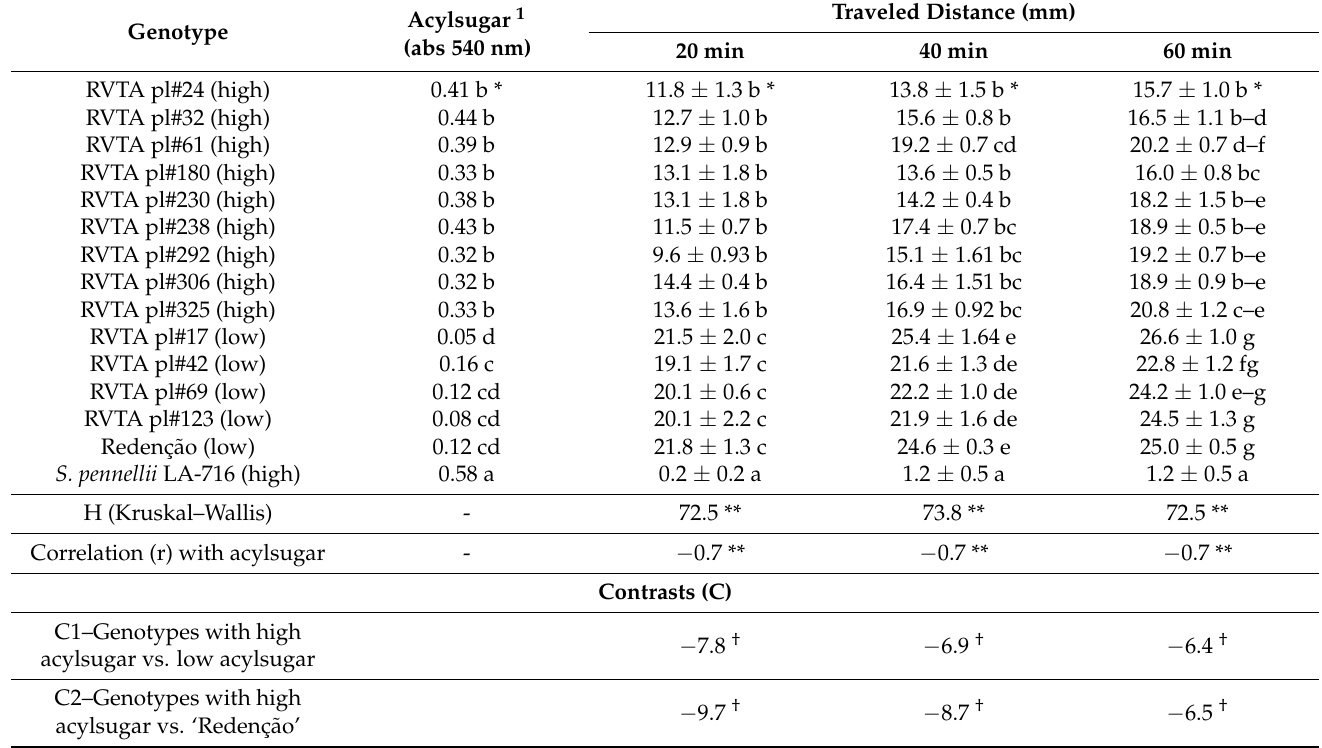
Table 5. Average ( ± standard deviation) distance covered by mites ( Tetranychus urticae ) at 20, 40, and 60 min after release of females on the abaxial surface of leaflets and correlation between acylsugar content and parameters analyzed in the no-choice behavioral test with F 2 BC 3 genotypes, performed at 20 ± 5 ◦